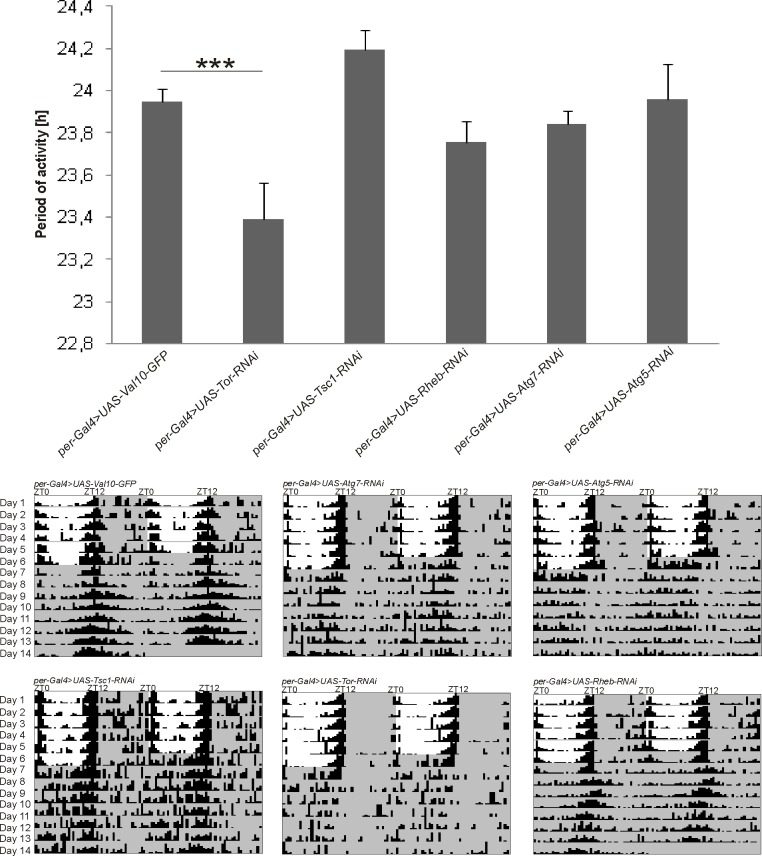
Periods of the locomotor activity rhythm of flies after silencing the expressions of studied genes.Tor, Tsc1, Rheb, Atg5 and Atg7 genes expression was silenced in per-positive cells. Period of locomotor activity rhythm was measured in DD conditions (mean +/- SE). Representative actograms were presented. As a control, the progeny of per-Gal4 and UAS-Val10-GFP crossing was used. After silencing the Tor gene, the period of locomotor activity rhythm was significantly shorter than in the control [U Mann-Whitney Test, *** for p≤0,001]. Silencing the Tsc1 gene caused a slight lengthening in the period of the rhythm.